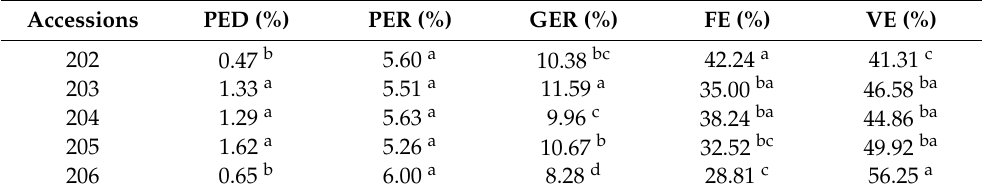
Table 3. Characteristics of the structural components of native corn grain from the Jalisco Highlands, Mexico. Accessions PED (%) PER (%) GER (%) FE (%) VE (%) 202 0.47 b 5.60 a 10.38 bc